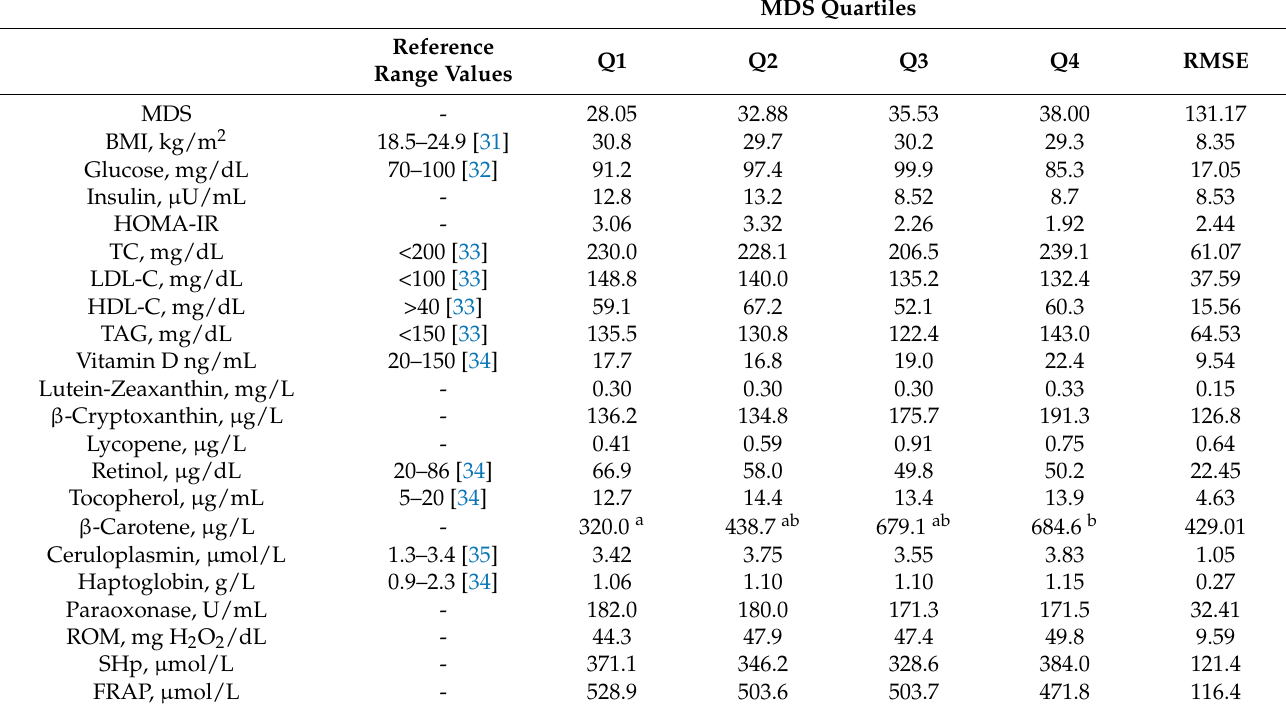
Table 1. Characteristics of enrolled